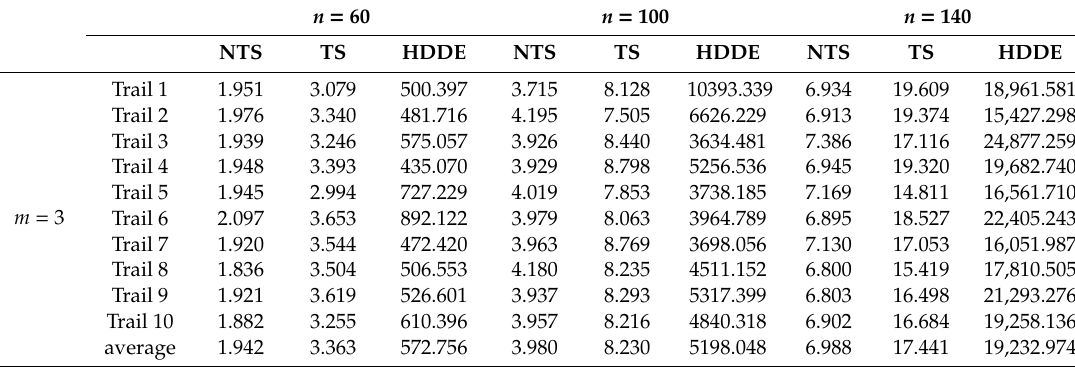
Table 3. Computational results of the NTS, TS and HDDE algorithms regarding running